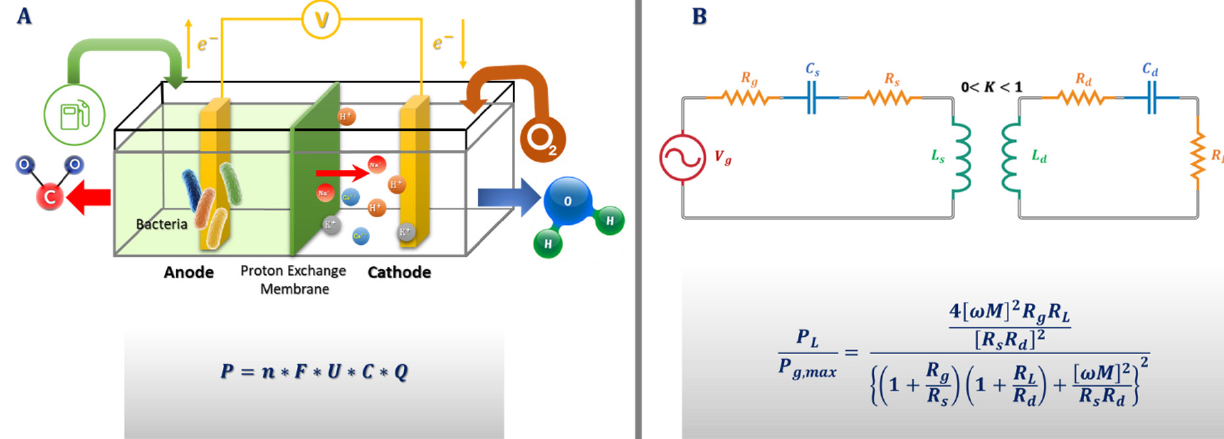
Figure 5. ( A ) Microorganisms producing energy as biofuel cells. P is the electric power, n the number of electrons released from one fuel molecule, F the Faraday constant, U the biofuel cell voltage, C the fuel concentration, and Q is the tear production rate. U values are based on the maximal theoretical (open circuit) voltages of glucose/oxygen. ( B ) Power transmission from transmitter to receiver on contact lenses—where V g is voltage gate, L s is source coil inductance, L d is device coil inductance, R s is transmitter resistance, R d is receiver resistance, R g is generator resistance, R L is load resistance, C s is source capacitor, C d is device capacitor, M is mutual coupling, K is the coupling coefficient and ω is the angular frequency of transmission. By using the maximum power transfer theorem, the ratio of load power ( P L ) to maximum output power ( P g,max ) available to the contact lenses can be given by the equation shown.